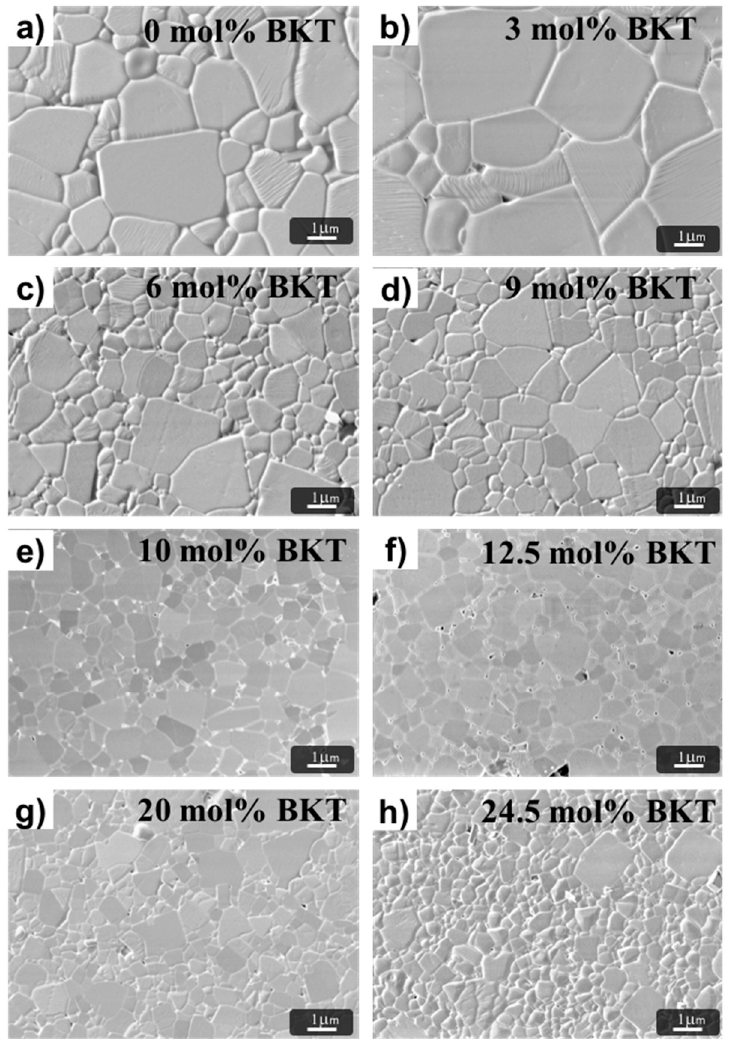
Figure 5. SEM micrographs of polished and thermally etched sintered ceramics in compositions (97.5 − x )BNT + x BKT + 2.5BT with x = 0, 3, 6, 9, 10, 12.5, 20, and 24.5 mol % BKT for ( a – h ), respectiely. Table 1. Average, mode, and interquartile range data of grain size distribution obtained from analysis of SEM micrographs for the studied compositions.